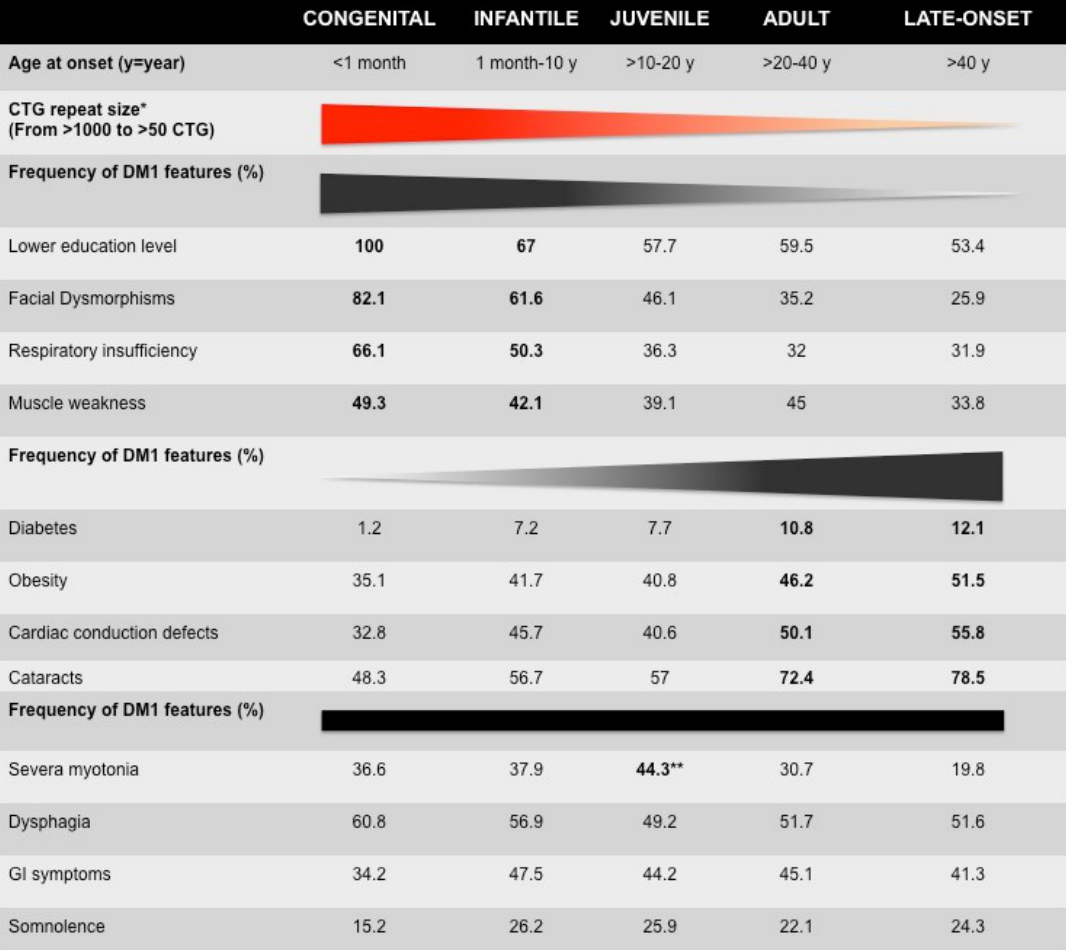
Figure 1. Clinical characteristics of French myotonic dystrophy type 1 (DM1) cohorts [6] . * The mean